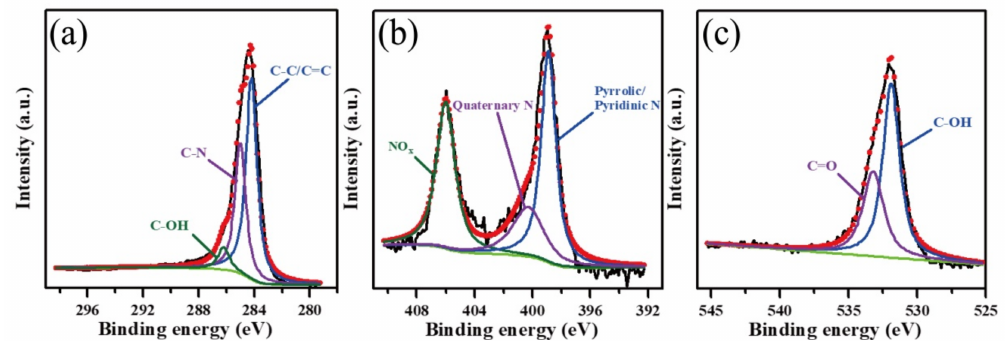
Figure 3. XPS spectra of N-CQD sample: ( a ) C1s peak, ( b ) N1s peak, and ( c ) O1s peak, deconvoluted by a multiple Gaussian